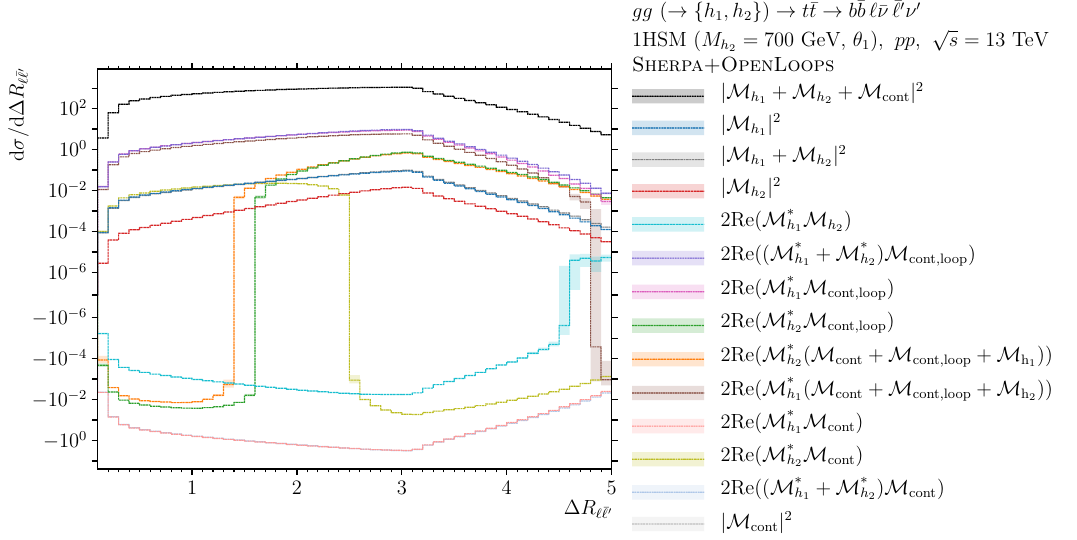
Figure 15 . ∆ R distributions for the signal process gg ( (cid:31) ¯ (cid:31) (cid:31) = 700 GeV, θ 1 ) including its interference with the background in pp collisions at the 1HSM ( M h 2 √ s = 13 TeV. Other details as in figure